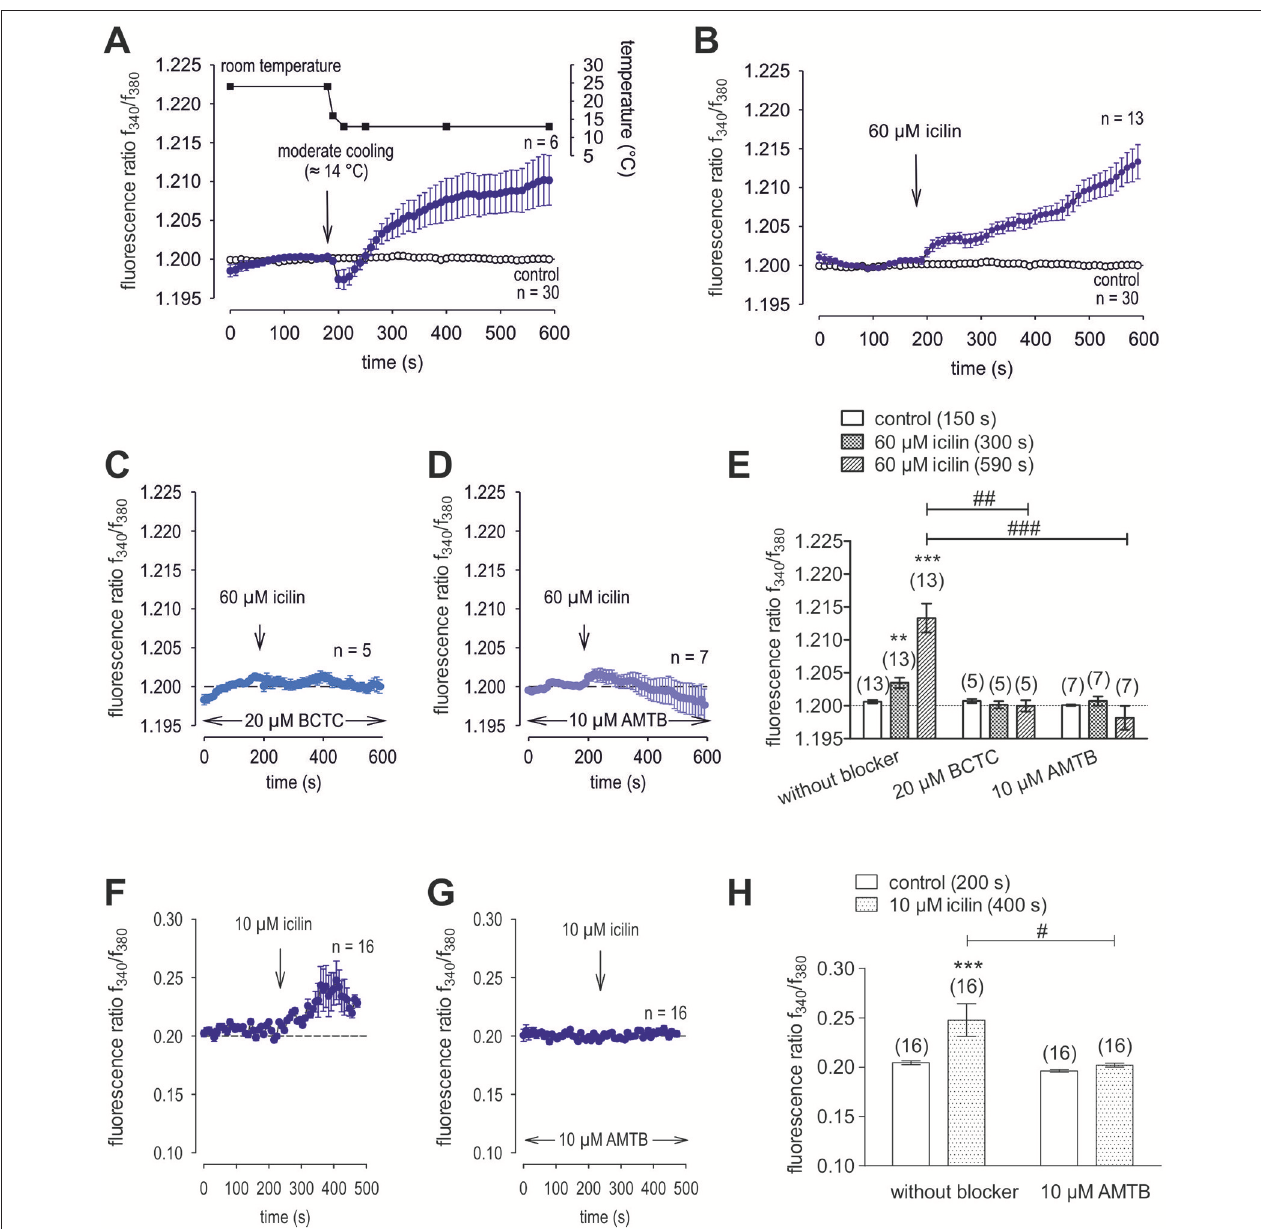
FIGURE 8 | Additional confirmation of functional TRPM8 expression in HCK. The thermal and pharmacological changes were carried out at the time points indicated by arrows. Data are mean ± SEM of 5-30 experiments. (A) Temperature lowering from ≈ 23 ◦ C to ≈ 14 ◦ C resulted in an increase [Ca 2 + ] i influx ( n = 6). The corresponding temperature time course is shown above the Ca 2 + traces. Untreated cells maintained stable [Ca 2 + ] i levels (control; n = 30). (B) Icilin (60 µ M) induced an irreversible increase in Ca 2 + influx ( n = 13) whereas non-treated control cells showed a constant Ca 2 + baseline ( n = 30). (C) Same experiment as shown in (B) , but in the presence of BCTC. BCTC (20 µ M) clearly suppressed the icilin-induced Ca 2 + increase ( n = 5). (D) Same experiment as shown in (B) , but in the presence of AMTB with the same result as obtained with BCTC ( n = 7). (E) Summary of the experiments with icilin, BCTC and AMTB. The asterisks (*) indicate significant differences between [Ca 2 + ] i levels with icilin and in the presence or absence of BCTC or AMTB ( n = 5–13; p < 0.01 at the minimum; paired tested). The hashtag (#) denotes a statistically significant difference in the fluorescence ratios between icilin with and without BCTC and AMTB, respectively ( n = 5–13; p < 0.01 at the minimum; unpaired tested). (F) Icilin (10 µ M) induced a partial reversible increase in Ca 2 + influx ( n = 16). (G) Same experiment as shown in (F) , but in the presence of AMTB. AMTB (10 µ M) suppressed the icilin-induced Ca 2 + increase ( n = 16). (H) Summary of the experiments with icilin. The asterisks (*) designate significant increases in [Ca 2 + ] i with icilin ( n = 16; p < 0.005; paired tested). The hashtag (#) denotes a statistically significant difference in fluorescence ratios between icilin with and without AMTB ( n = 16; p < 0.05; non-paired